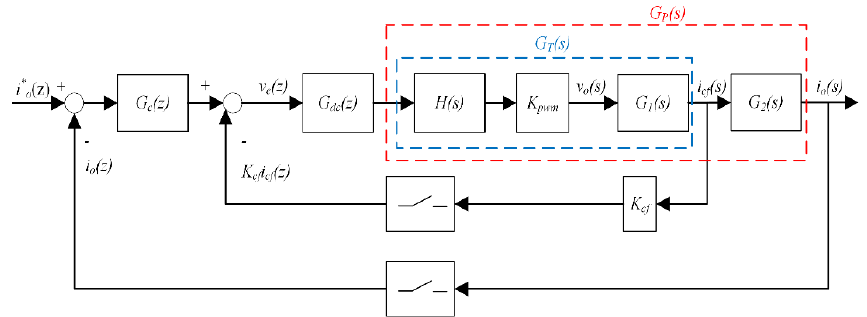
Figure 10. Model of ARSI in digital control.